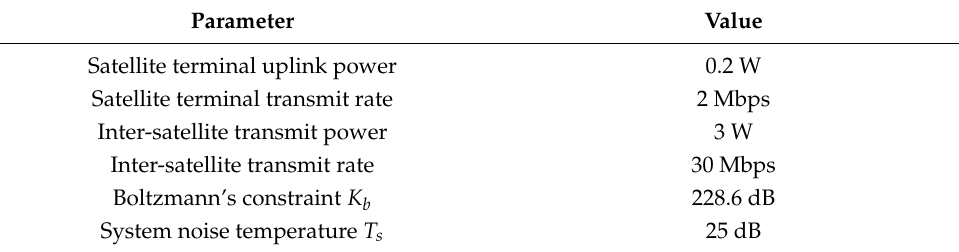
Figure 7. Constellation 3 snapshot. Table 4. Communication